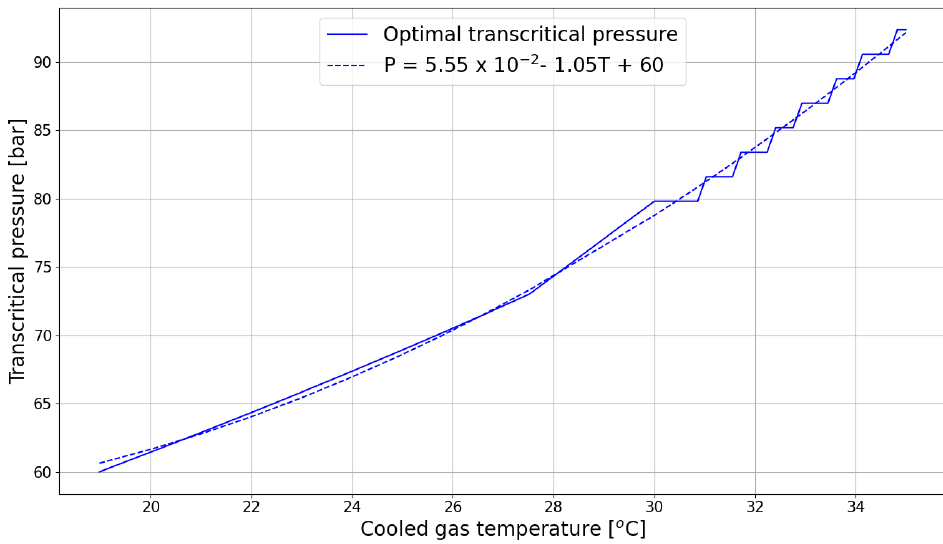
Figure 8. Parameterized backpressure setpoint used to optimise